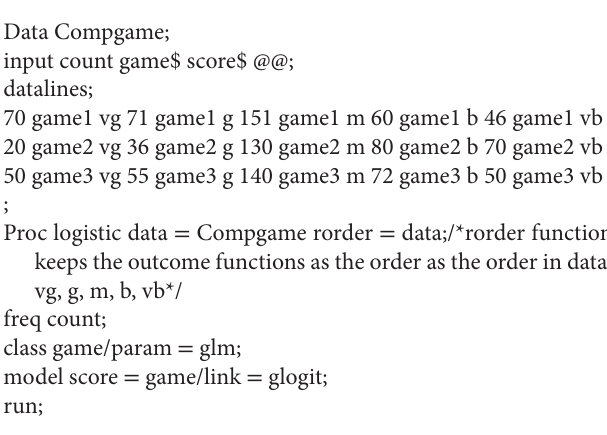
There are four outcome functions for the log odds compared with the very bad rating group (reference group): ln( p (vg)/ p (vb)), The SAS codes are: